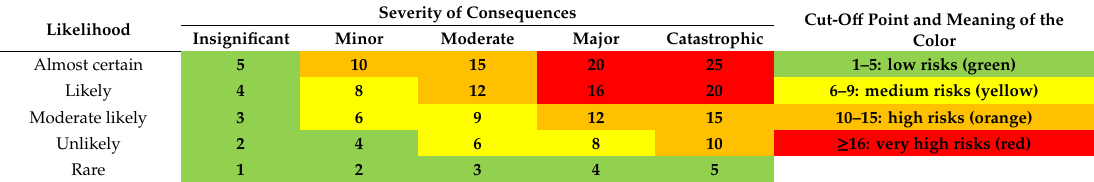
Table 1. Five-cell risk assessment matrix for drinking water risk management plans (RMPs).